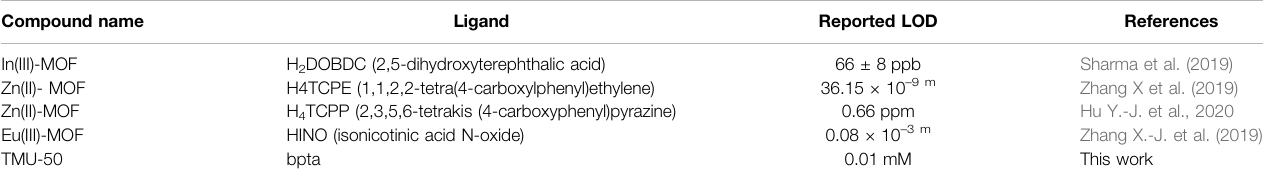
TABLE 1 | Comparison of Detection Limit (LOD) of several reported MOFs in nitrophenol